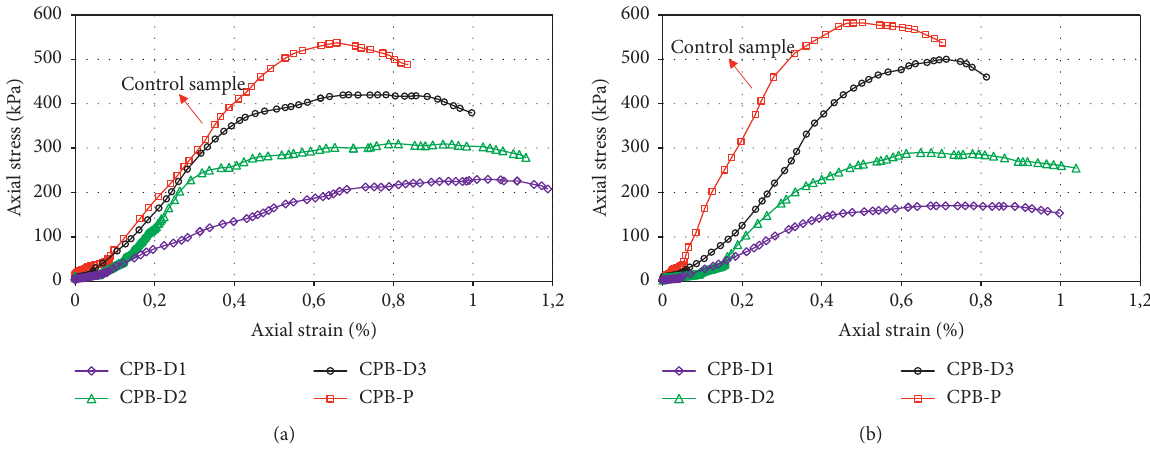
Figure 4: Change in axial stress with axial strain for diverse mine backfills: (a) 28 days and (b) 56